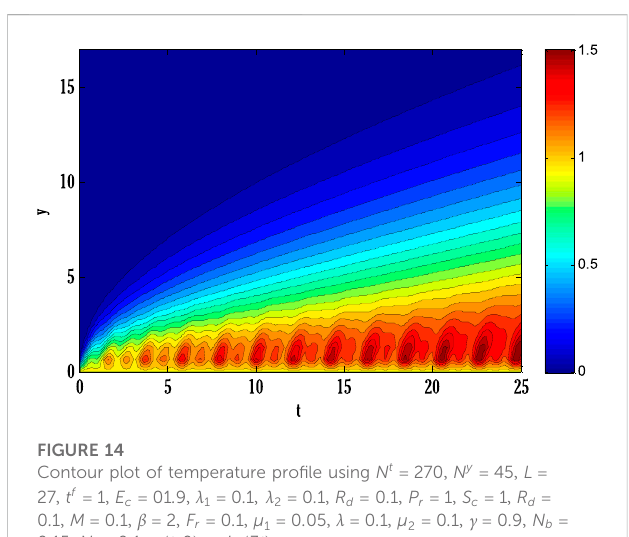
FIGURE 16 Comparison of the proposed scheme with the exact solution for Stokes ׳ second problem.